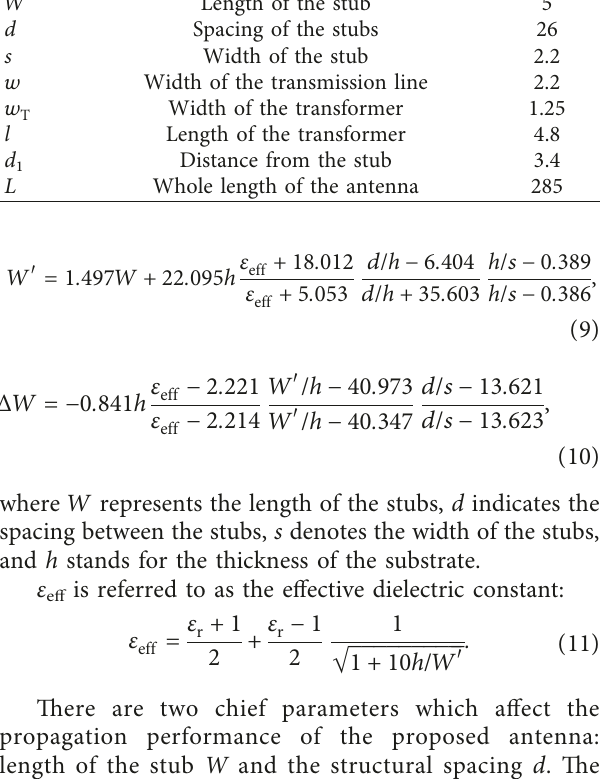
Table 1: Parameters of the radiation patch. Symbol Parameter Size (mm)